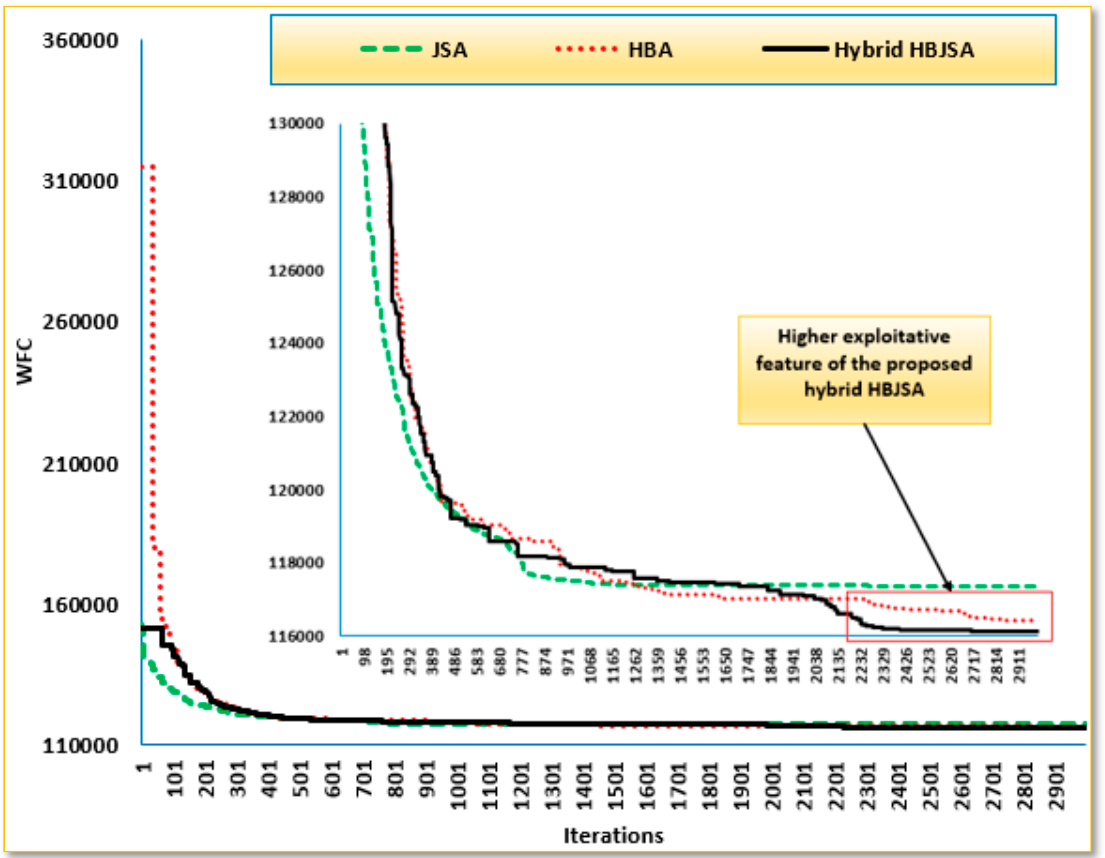
Figure 6. Convergence characteristics of the proposed HBJSA versus the HBA and JSA for the 48-unit system of CHP economic dispatch.